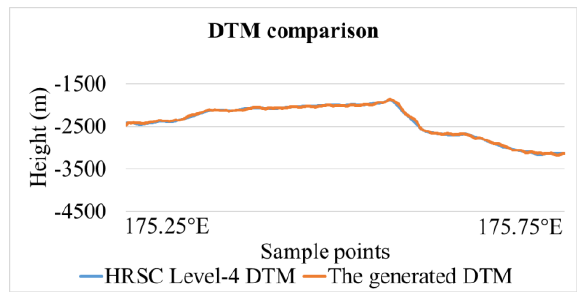
Figure 3. The terrain profiles comparison between the generated Martian DTM and HRSC Level-4 DTM.